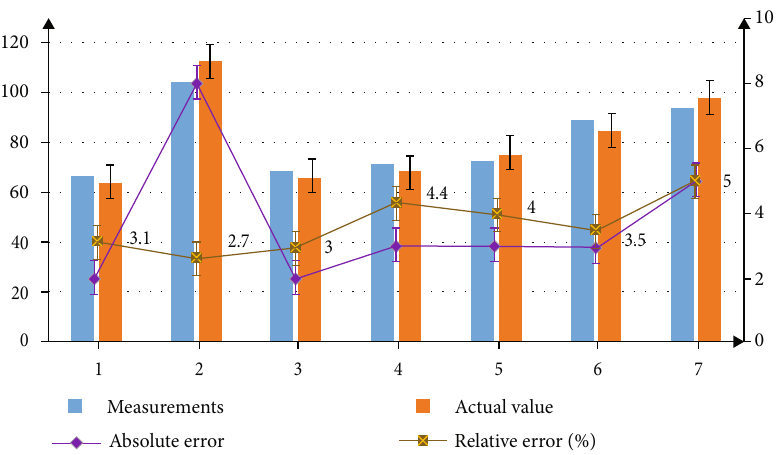
Figure 6: Analysis of the accuracy of heart rate measurement.